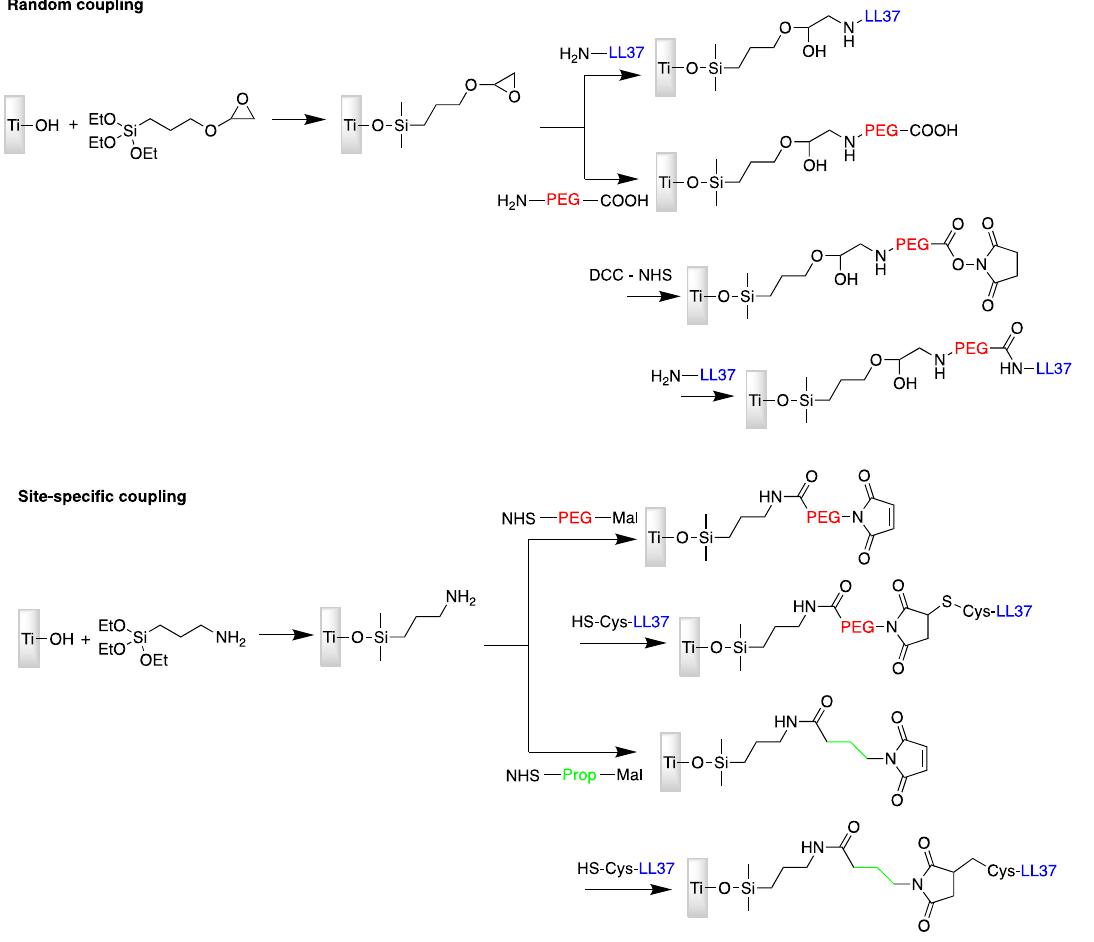
Figure 6. Random and site-specific strategies for coupling cathelicidin (LL-37) to titanium surface. Mal = maleimide; prop = propyl; PEG = poly(ethylene glycol).